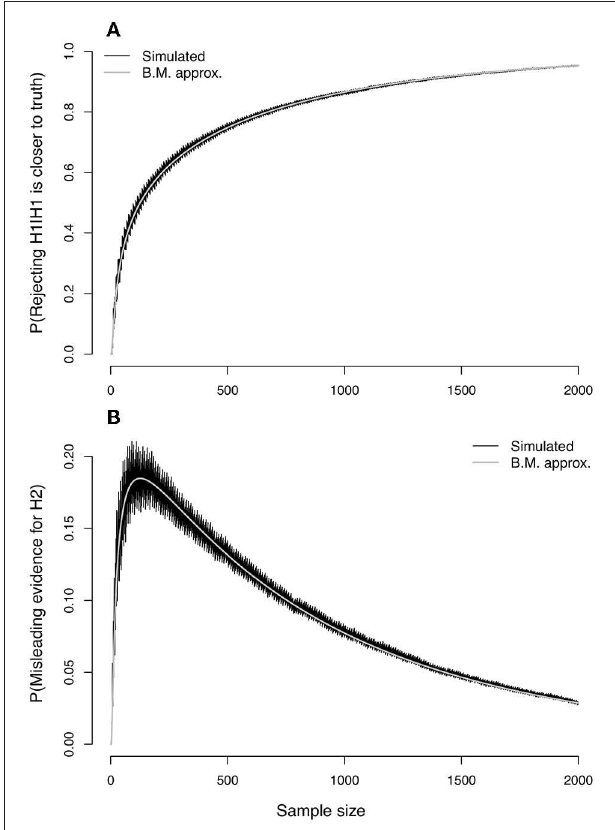
FIGURE 6 | Evidence error probabilities for comparing two Bernoulli( p ) distributions, with p 1 0.75 and p 2 0.50, when the true data-generating = = model is Bernoulli with p 0.65. (A) Simulated values (jagged curve) and = values approximated under the Central Limit Theorem of the probability ( α ′ ) of rejecting model H 1 when it is closer than H 2 to the true model. (B) Simulated values (jagged curve) and approximated values for the probability ( M ′ 1 ) of misleading evidence for model H 2 when model H 1 is closer to the true data-generating